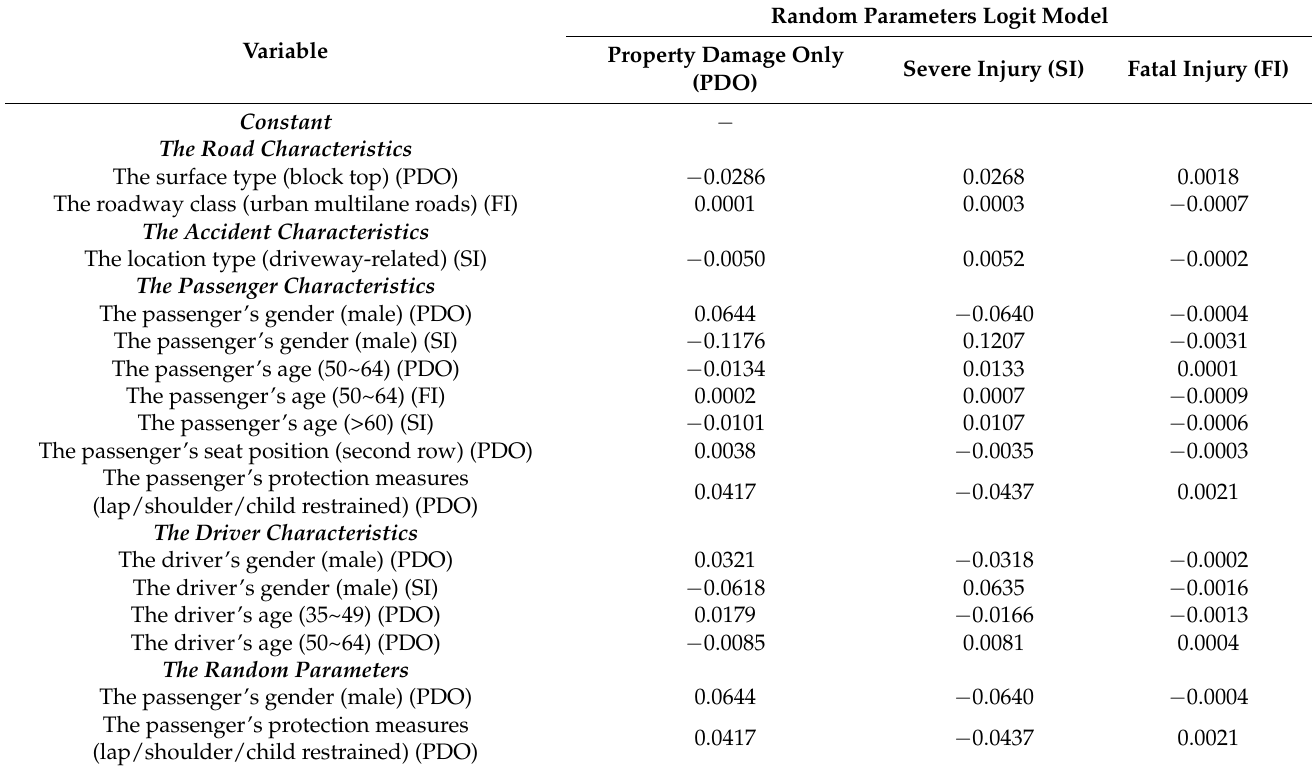
Table 8. The marginal effects of 2018 in daylight conditions.